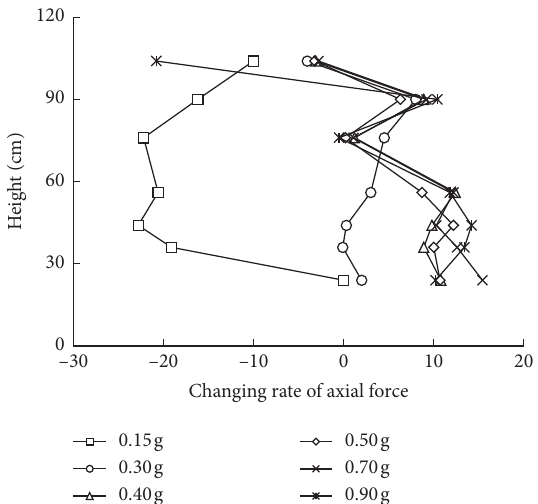
Figure 12: Variations of the changing rate of axial force under seismic motions with different